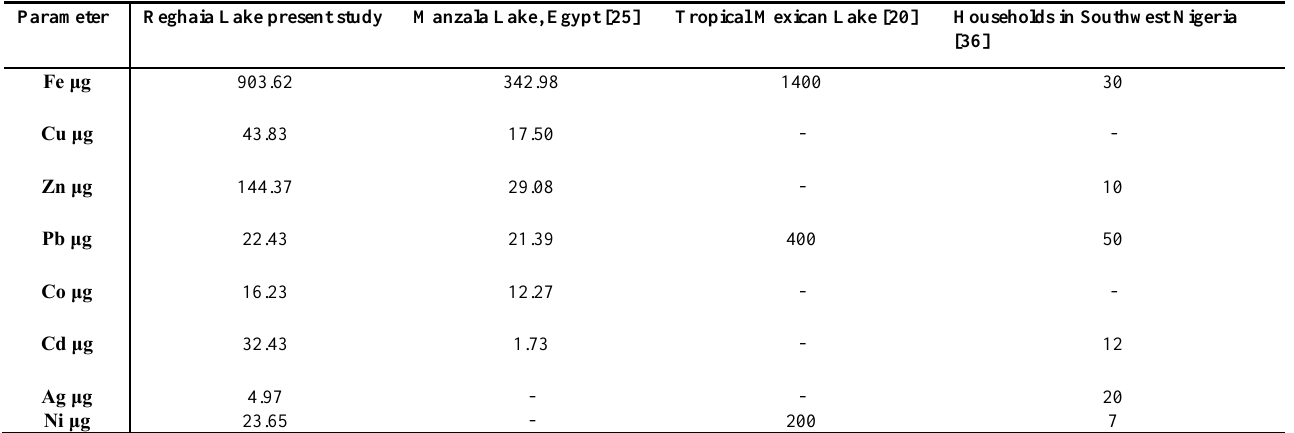
Table 6 . Comparison of the results of MTE with other authors.